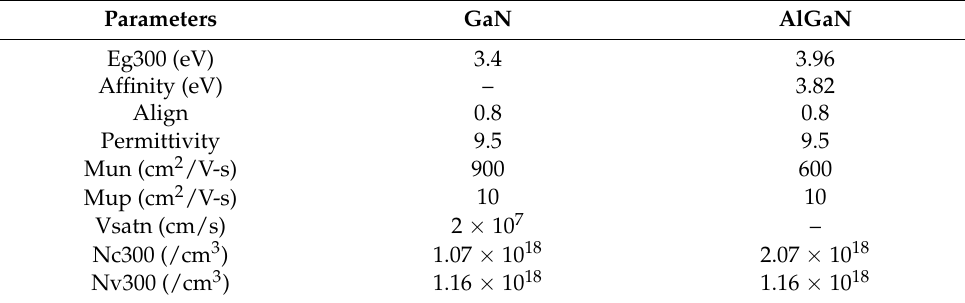
Table 1. Calibration semiconductor parameters for GaN and